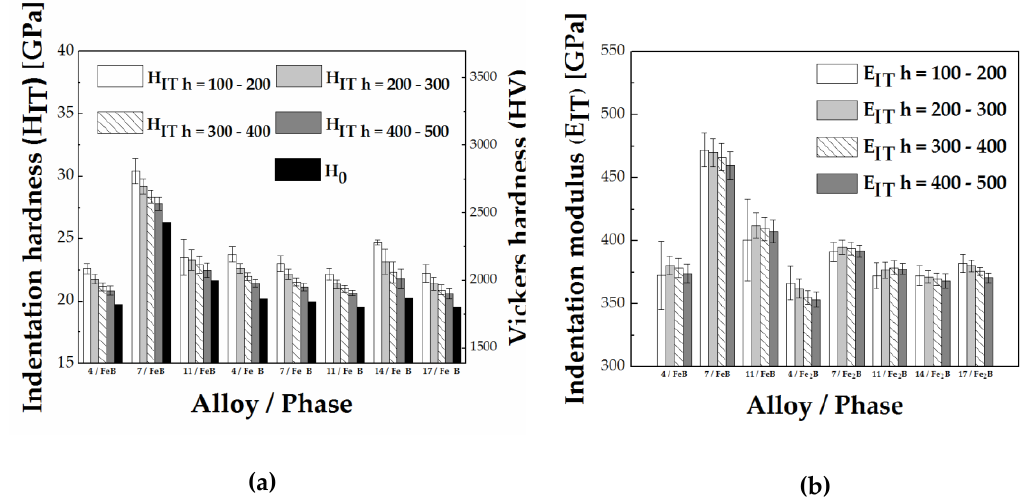
Figure 11. ( a ) Indentation hardness, H IT , as average values in indentation depth intervals of h = 100–200,